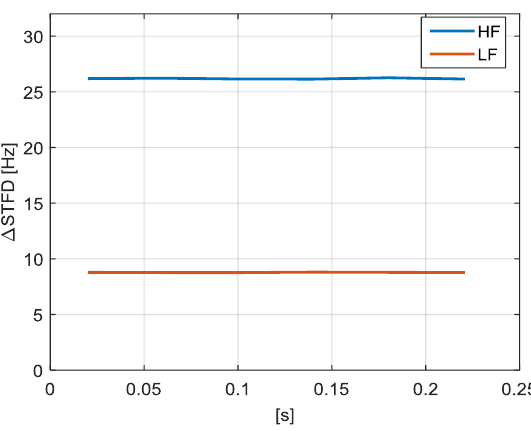
Figure 26. Case study 1: Δ STFD at low-frequency (0 ÷ 2 kHz, red line) and at high-frequency (2 ÷ 150 kHz, blue line) obtained through STFT. Energies 2017 , 10 , 1633 23 of 39